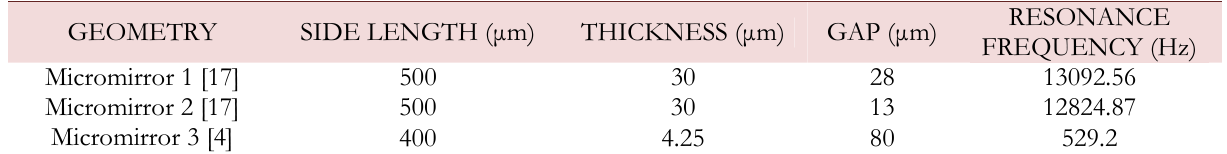
Table 1: Geometry and resonance frequency of the torsion micromirrors reported by Minikes et al. [17] and Pandey and Pratap